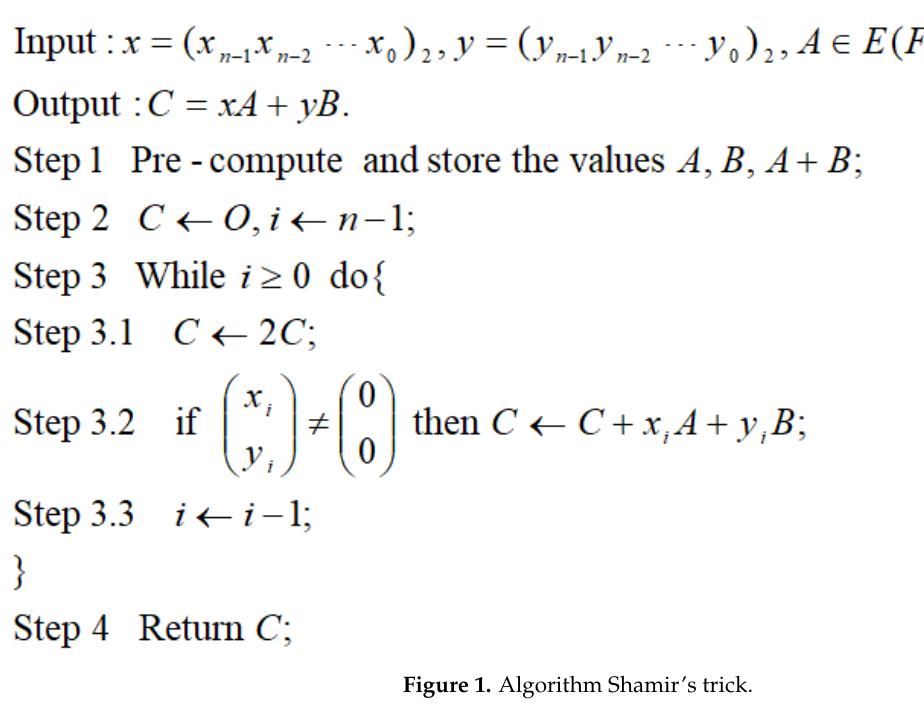
Figure 1. Algorithm Shamir’s Figure 1. Shamir’s trick.